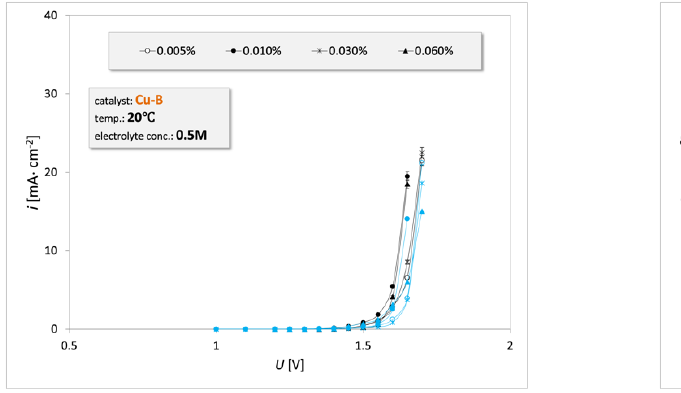
( b ) Figure 9. Electrooxidation curves of WEO emulsion (black lines) and detergent (blue lines) for var- ious concentrations of detergent and emulsion on the Ni-Co catalyst for an electrolyte concentration of 2 M. Electrooxidation: ( a ) temperature: 60 °C; ( b ) temperature: 80 °C.